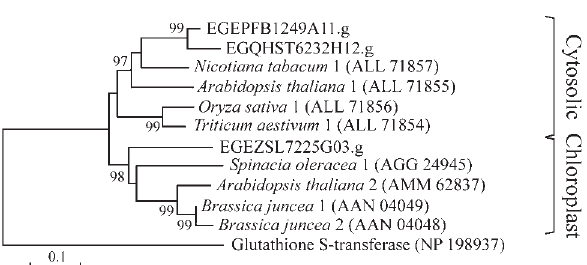
Figure 6 - Phylogenetic tree of DHAR proteins. Phylogenetic analyses were conducted as described in Figure 2.